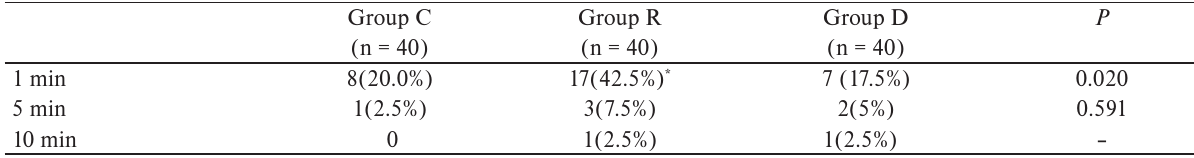
Table 4. The percentage of neonates with an Apgar score